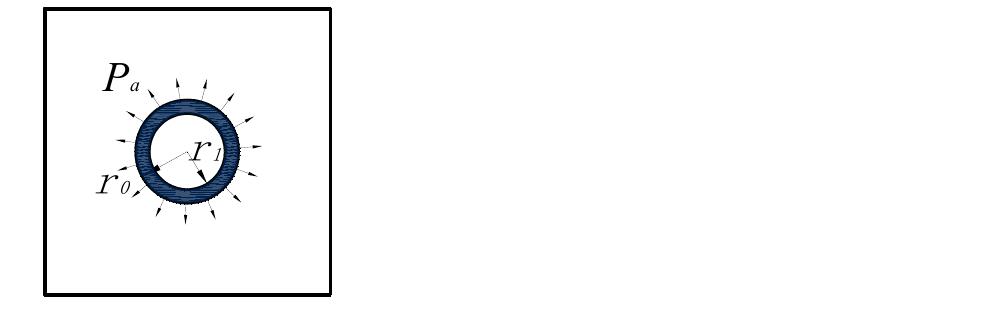
Figure 3. Stress state of the surrounding rock supporting structure.